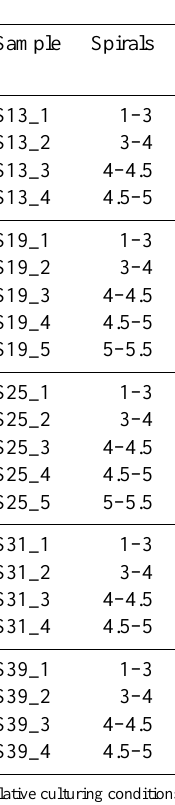
Table 3. Stable isotope results of snail individual fractions and the estimated contributions of their shell carbon sources.